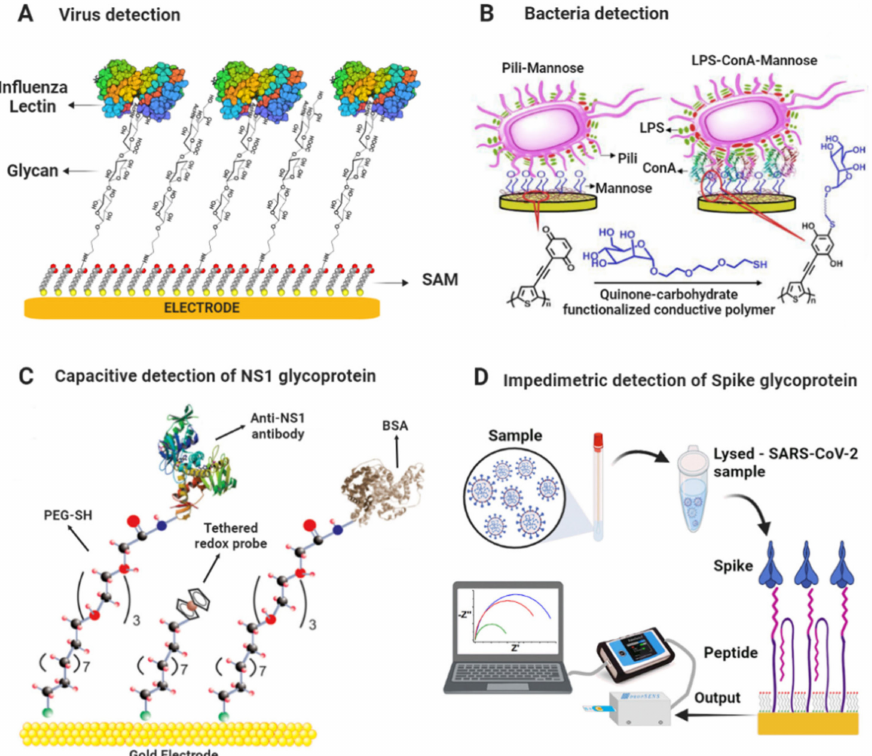
Figure 3. Scheme of glycobiosensors for pathogen detection. ( A ) Glycan-based biosensor for